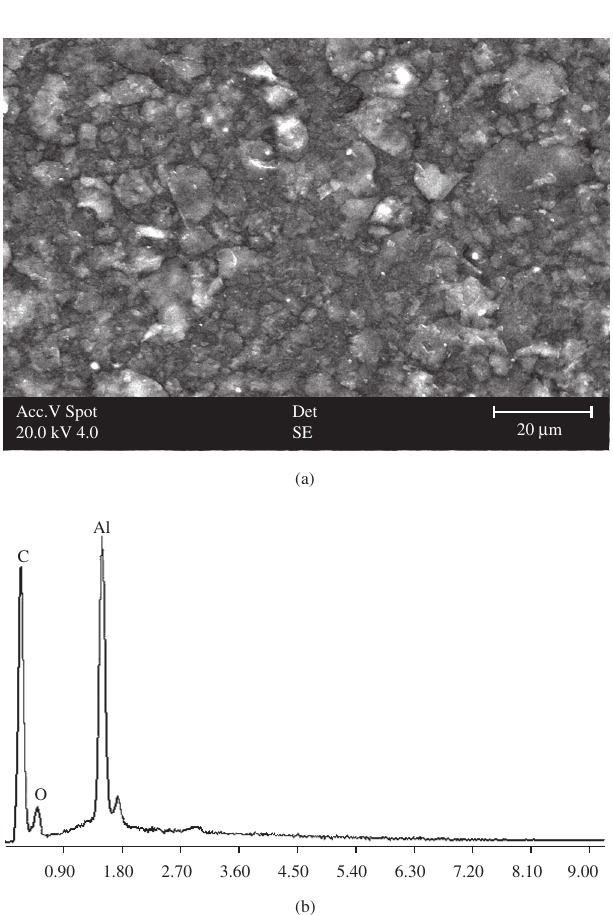
Figure 1. The morphology: a) revealing lamellar particles and the EDS spectrum; and b) of the aluminium based paint.